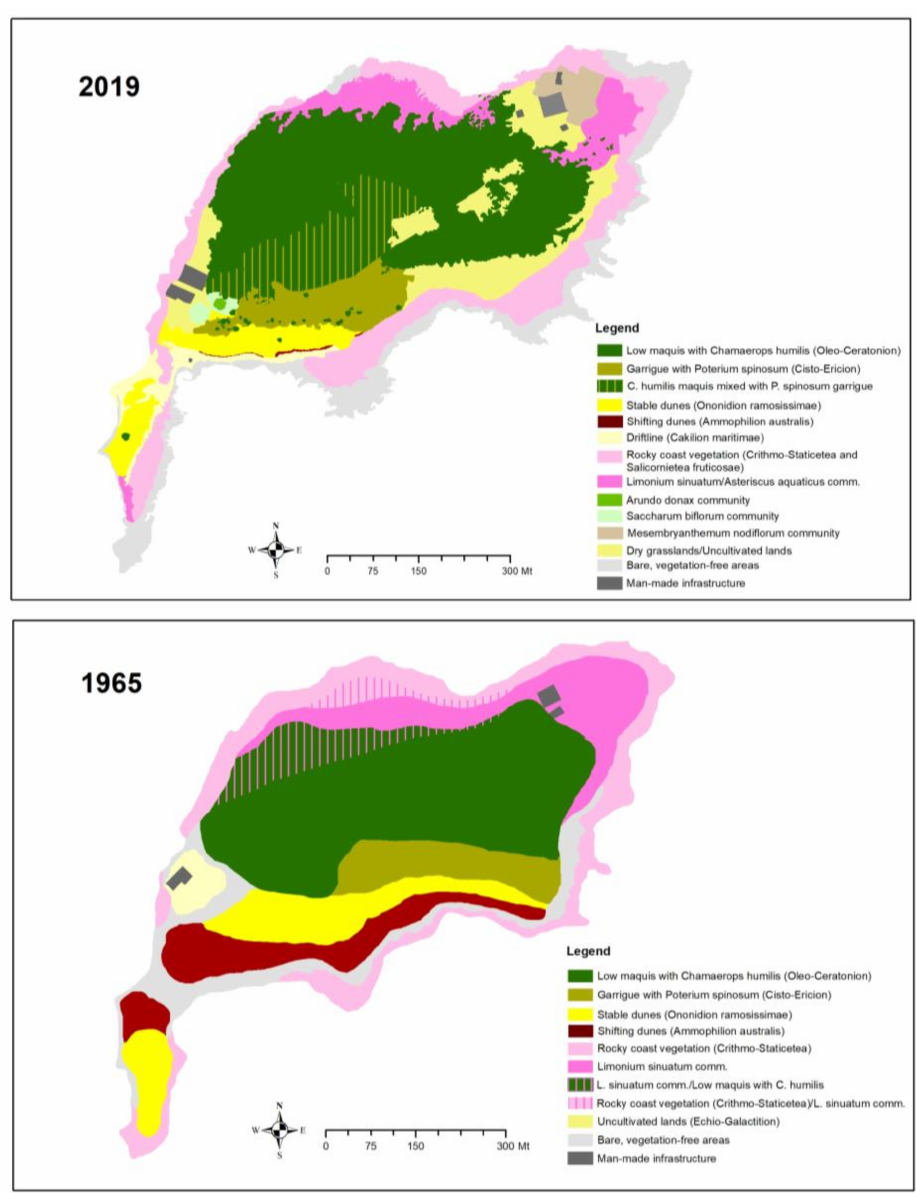
Figure 5. Comparison between the vegetation map published by Pirola (1965) and the one produced by the authors combining the interpretation of recent aerial photos (2019) and field surveys. The list of the plant communities is shown in the legend included in each map. The corresponding habitats (according to European Directive 92/43 CEE) for each plant communities are listed in Table